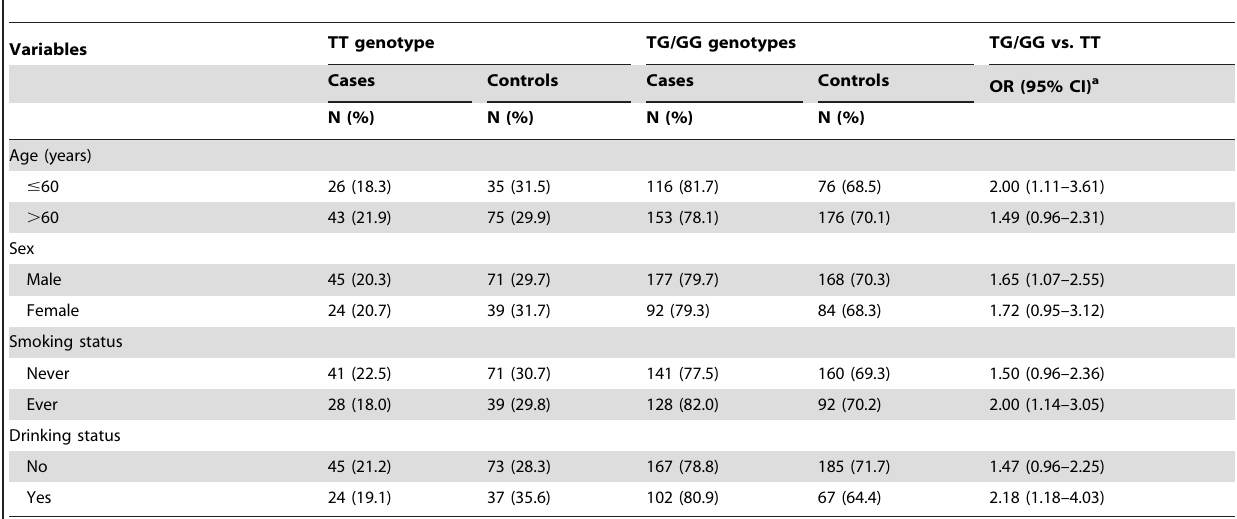
Table 3. Stratified analyses for the APE1 T1349G polymorphism in gastric cancer cases and control